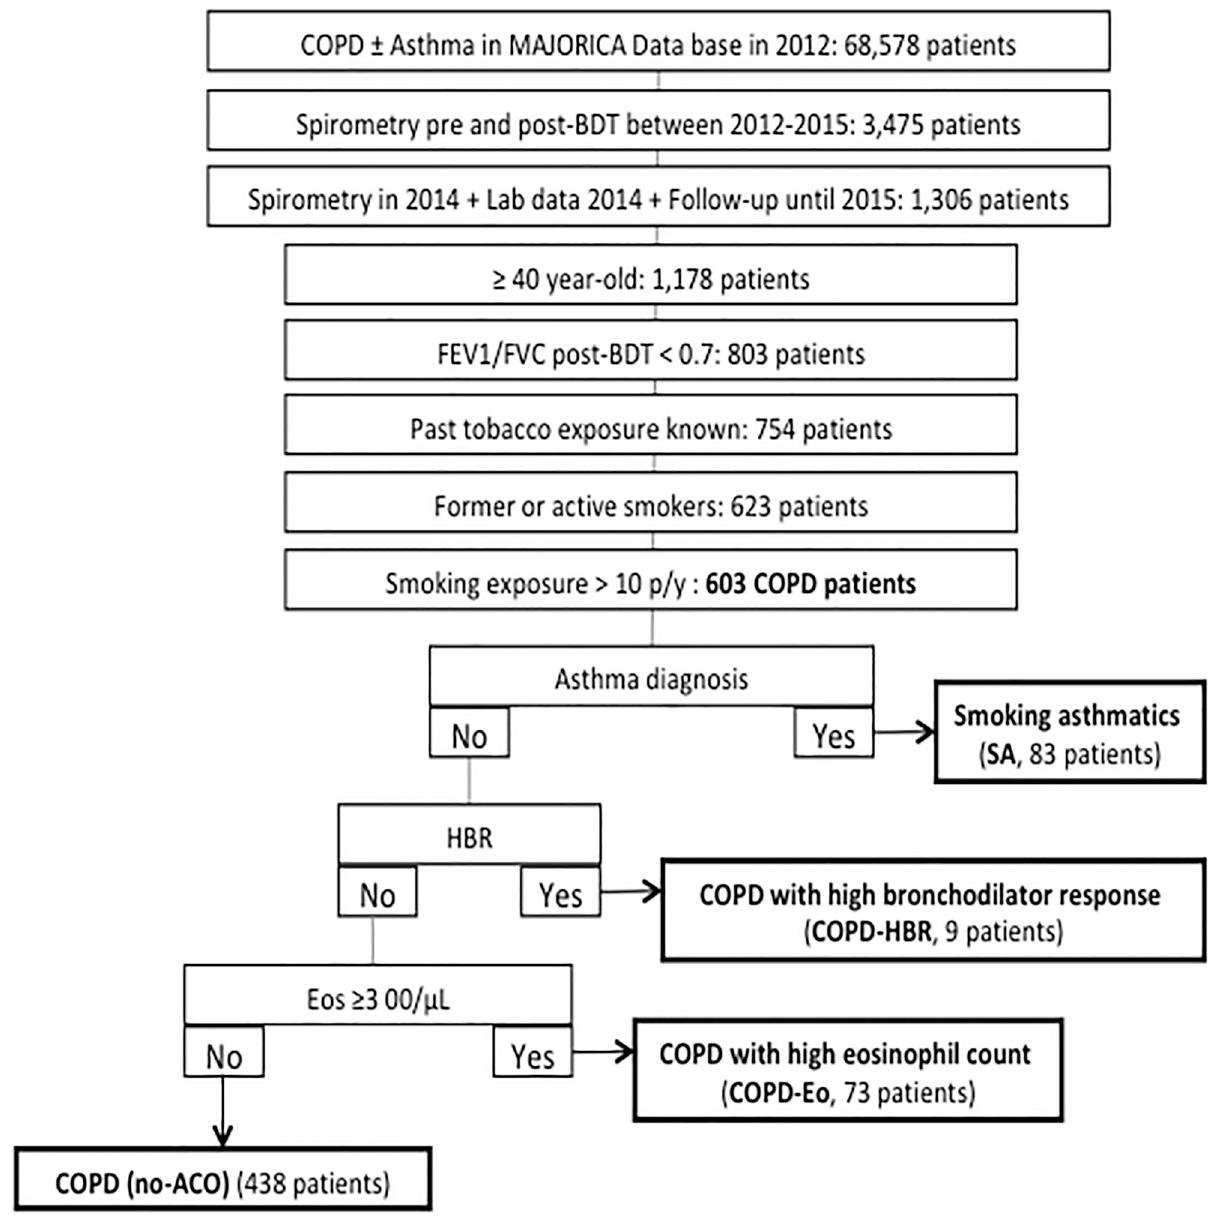
Fig 1. STROBE flow-chart. COPD: chronic obstructive pulmonary disease; BDT: bronchodilator test; FEV1: forced expiratory volume in the first second; FVC: forced vital capacity; p/y: pack-years; SA: smoking asthmatic; Eos: eosinophil; ACO: asthma-COPD overlap; HBR: high bronchodilator